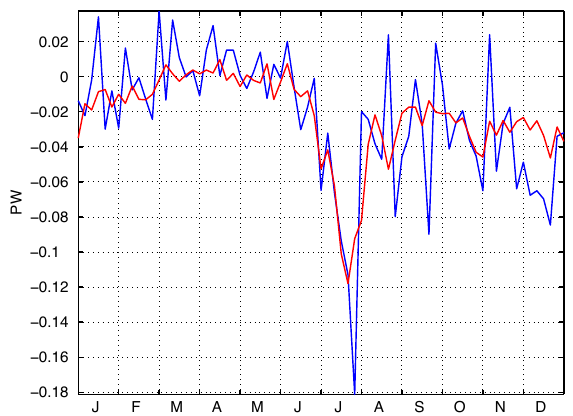
Fig. 6. Results for the northern region: Estimates of the heat flux er- ror (in PW) due to neglecting short term fluctuations (blue – Eq. A6) compared with, in red, the difference between the actual change in model heat content and that estimated from the 5-day mean